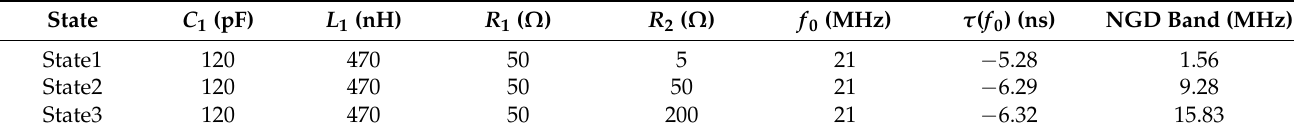
Table 3. Data of band-pass negative group delay circuit with different R 2 .